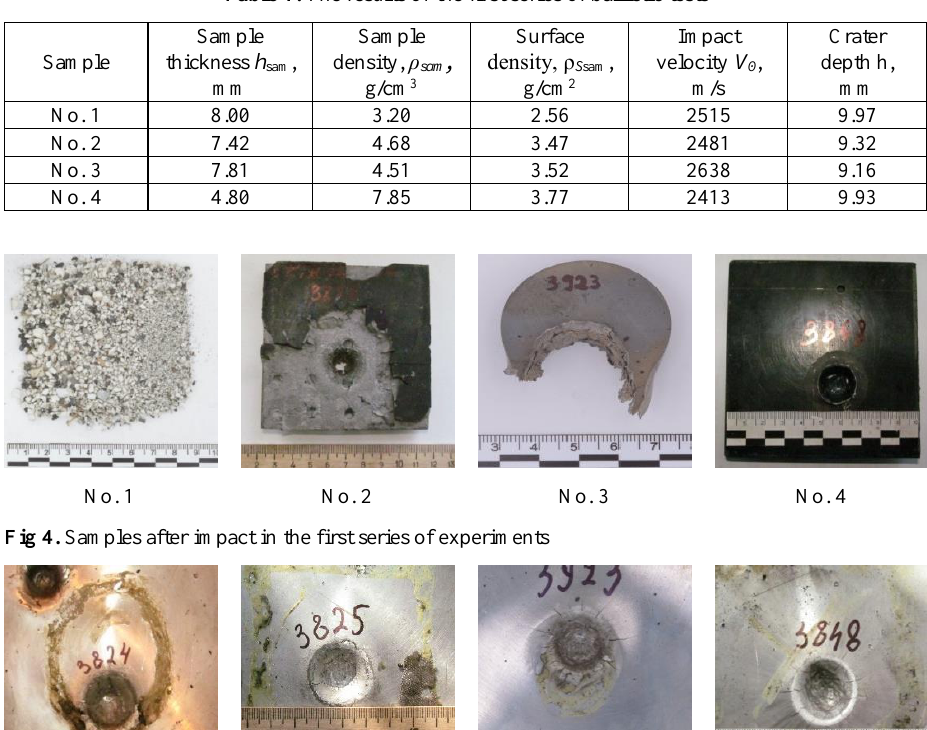
Table 1. The results of the first series of ballistic tests